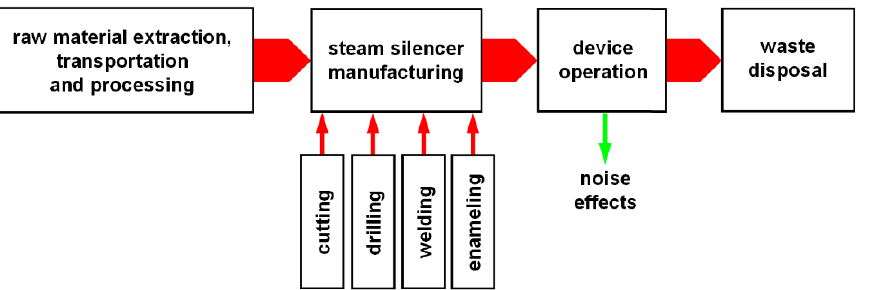
Figure 1. The scope of the analysis.